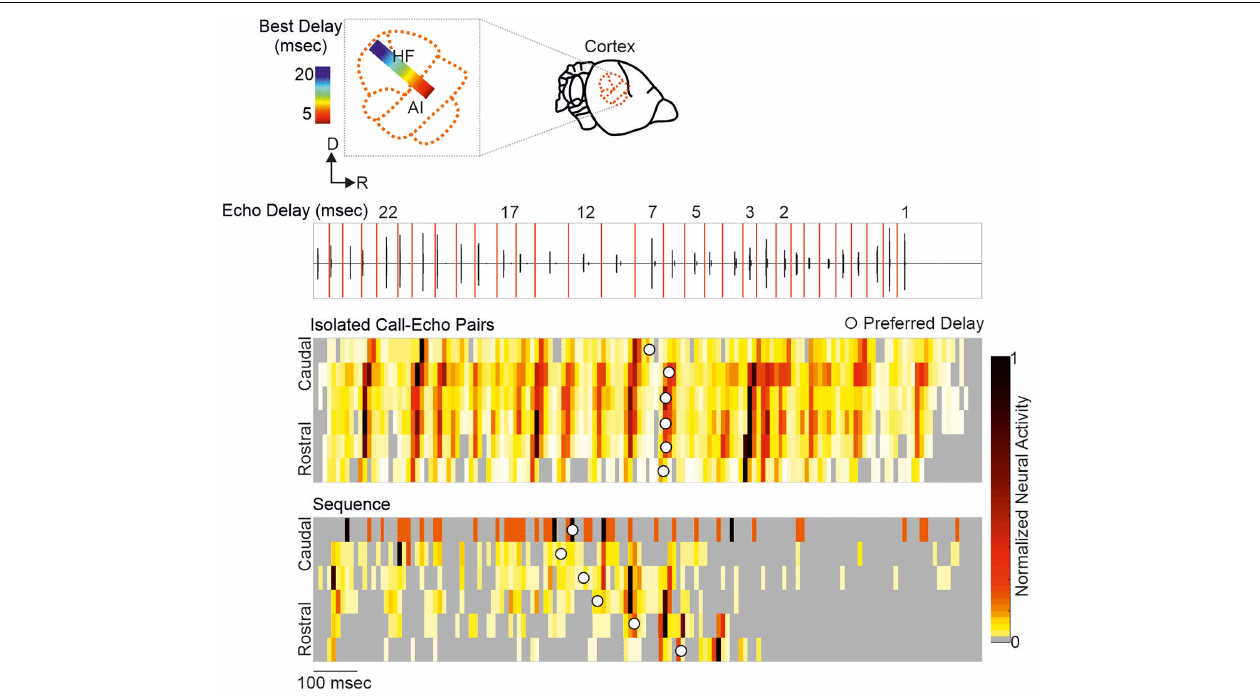
FIGURE 3 | A neural activity wave travels across the cortex when the bat is stimulated with a naturalistic echolocation sequence of an approach flight, but it is absent when presenting the same call-echo pairs in randomized order. Top: Schema of the chronotopic gradient of the auditory cortex in Carollia perspicillata . Neurons tuned to long delays ( ∼ 20 ms) are clustered in caudal regions while short delays ( ∼ 2 ms) are primarily processed in rostral regions of the cortex. Bottom: Oscillogram of the stimulus. Red vertical lines border the call-echo pairs. Heatmaps represent the neural activity of six simultaneously recorded units in response to temporally isolated call-echo pairs (Top) and to the naturalistic echolocation sequence (Bottom) . The naturalistic echolocation sequence contained the same acoustic information as the call-echo pairs that were played randomly with a 500 ms inter-stimulus interval. Only the temporal context, i.e., stimulus history and the stimulus rate differ between both stimulation protocols. Units are ordered along the rostro-caudal axis. Preferred echo delays, median time points of the neural responses of each unit are indicated as white dots. Data adapted from Beetz et al.